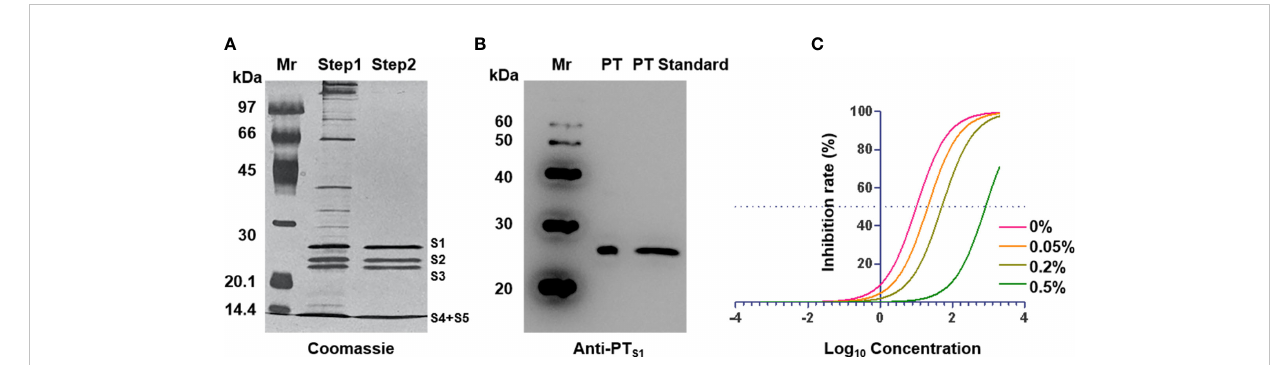
FIGURE 2 Characterization of pertussis toxin. (A) Identi fi cation of puri fi ed pertussis toxin by SDS-PAGE. (B) Identi fi cation of puri fi ed pertussis toxin by western blot with anti-PT S1 . (C) ELISA inhibition curves after treatment of PT with different concentrations of glutaraldehyde. Mr: